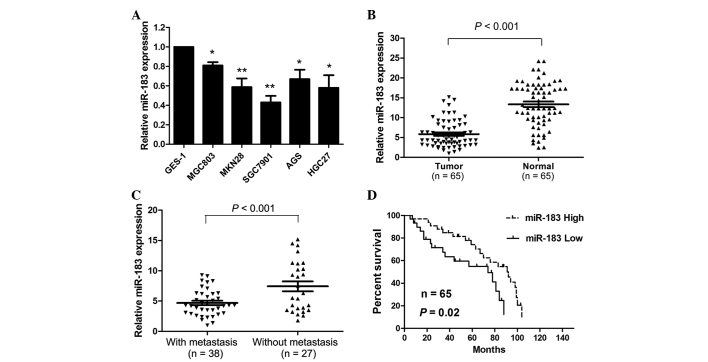
miR-183 is significantly downregulated in gastric cancer cell lines and tissues. (A) Relative miR-183 expression levels in gastric cancer cell lines and GES-1 normal gastric epithelial cells (*P<0.05; **P<0.01). (B) Relative miR-183 expression levels in gastric cancer tissues and adjacent normal tissues (P<0.001). (C) Relative miR-183 expression levels in gastric cancer tissues with and without distant metastasis (P<0.001). (D) Kaplan-Meier curve indicating overall survival rates of gastric cancer patients with high (n=33) and low miR-183 expression levels (n=32; P=0.020). miR, microRNA.